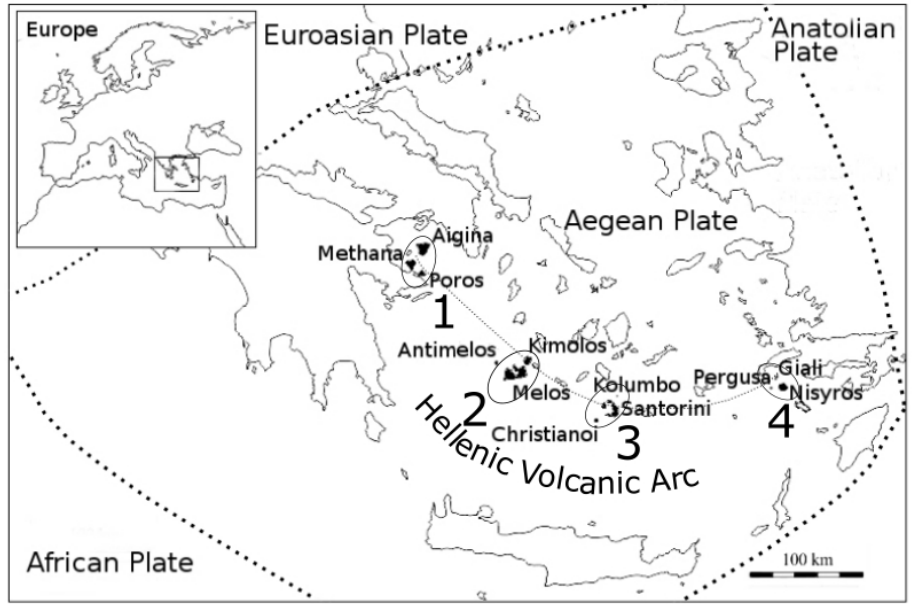
Figure 1. The Hellenic Volcanic Arc: 1. Methana group, 2. Melos group, 3. Santorini group, and 4. Nisyros group.